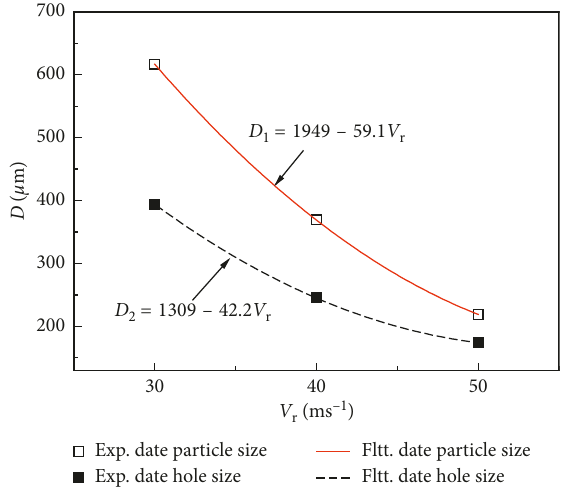
Figure 4: Particle size and hole size of Ni-5% Pb alloy hollow particles versus